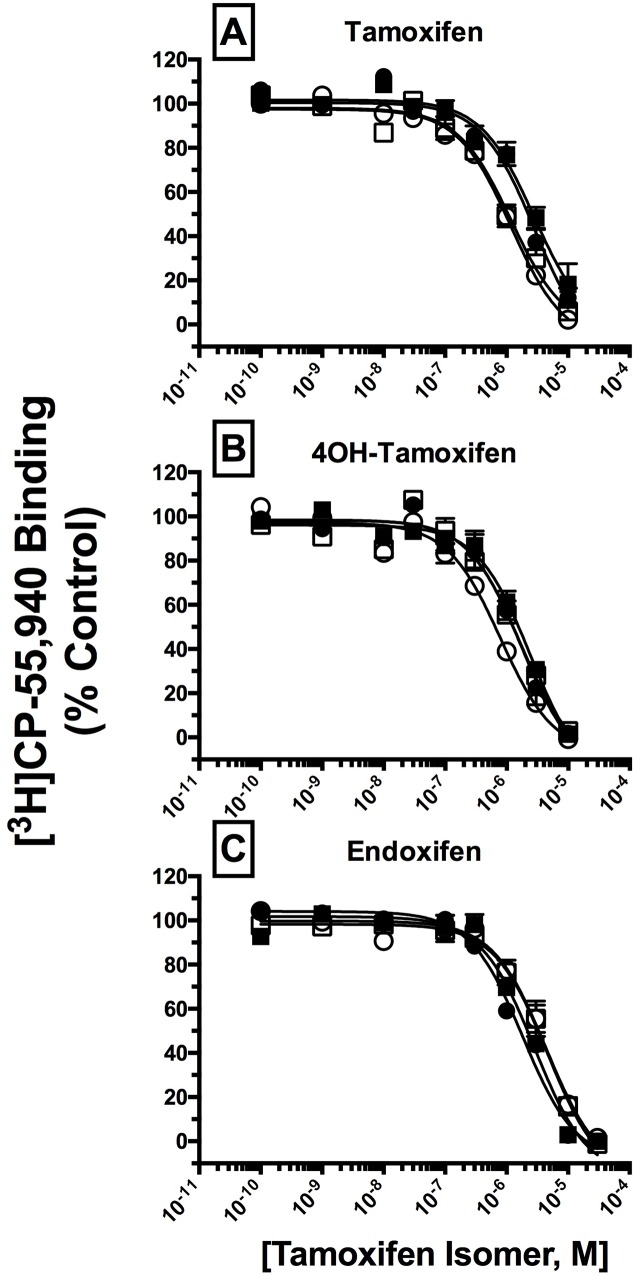
SERM isomers exhibit mid-nanomolar to low-micromolar affinities for CB1 and CB2Rs.A measure of affinity (Ki) of E and Z isomers of Tam, 4OHT, and End for respective CB1 and CB2Rs was obtained by conducting competition binding studies, employing 0.2 nM [3H]-CP-55,940 and increasing concentrations of test compounds. Ki values (mean ± SEM) were derived from non-linear regression analysis of the curves shown in [A-C]. Individual Ki values and statistical analysis of pKi values are presented in Table 1. Filled squares and circles represent binding of respective E and Z isomers to CB1Rs, open squares and circles represent binding of respective E and Z isomers to CB2Rs.